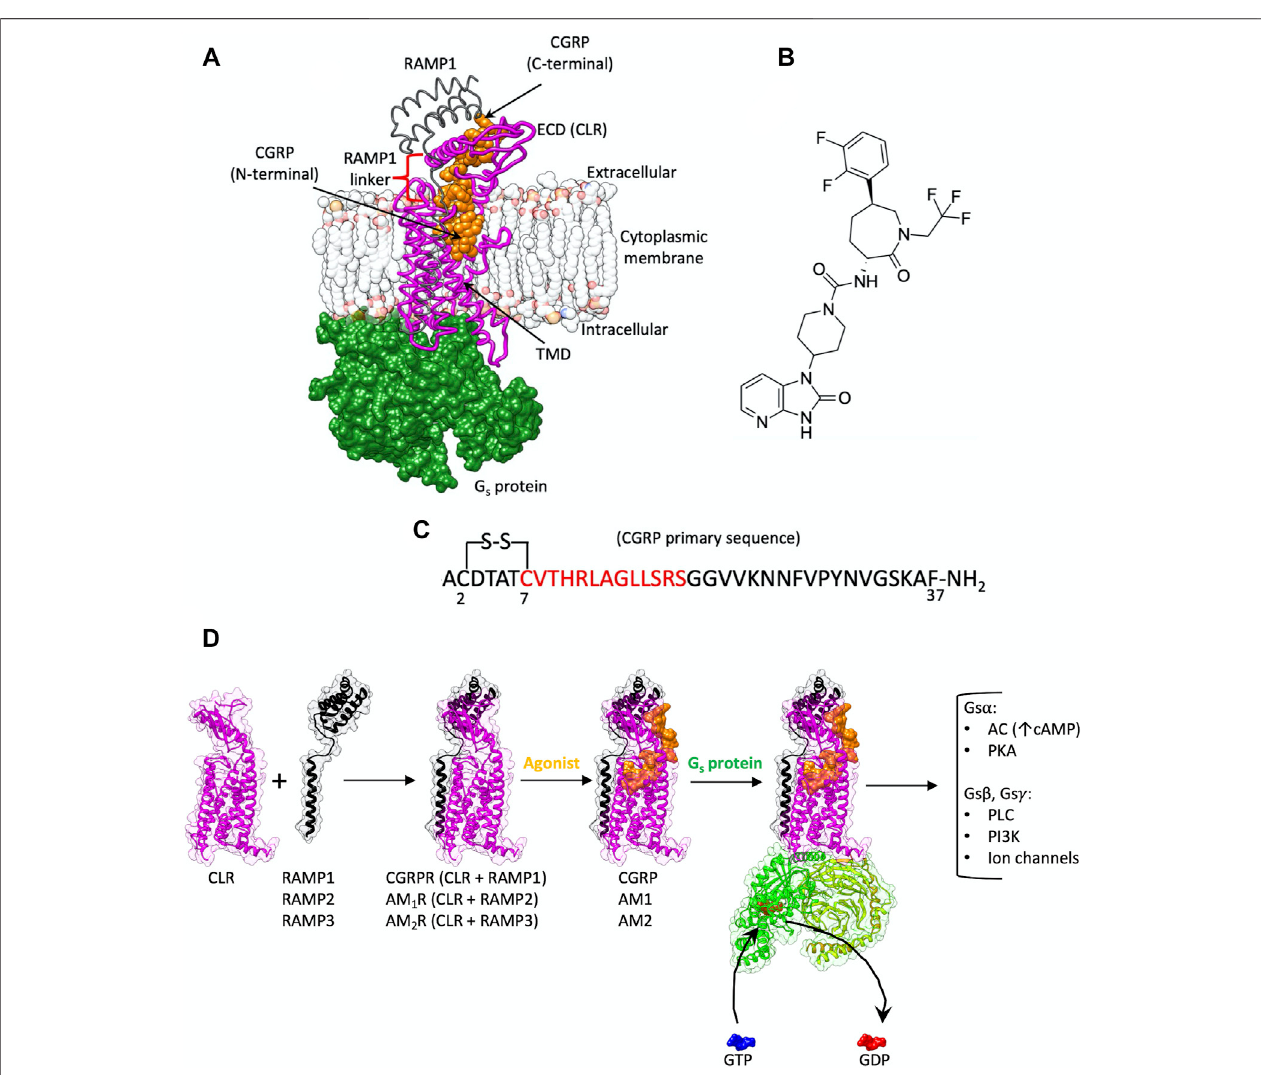
FIGURE 1 | (A) CGRPR is a heterodimer membrane protein composed of CLR (purple ribbon) and RAMP1 (gray ribbon); CGRP (orange van der Waals spheres) binds to the TMD and extends towards the ECD. Agonist-bound CGRPR couples to G s protein (green surface). (B) Chemical structure of the CGRPR antagonist telcagepant. (C) CGRP primary sequence; the residues in the N-terminal helix are indicated in red. (D) Schematic representation of the events from the heterodimerization between CLR and RAMPs to G protein signaling. The formation of complexes between CLR and different RAMPs generate receptors with selectivity towards CGRP, AM1 or AM2; upon agonist binding, the trimeric G s protein is recruited and activated, favoring the exchange between GDP and GTP at the level of the G s α subunit. After G s subunits dissociation multiple intracellular signaling pathways are triggered (AC, adenylyl cyclase; PKA, protein kinase A; PLC, phospholipase C; PI3K, phosphoinositide 3-kinases).